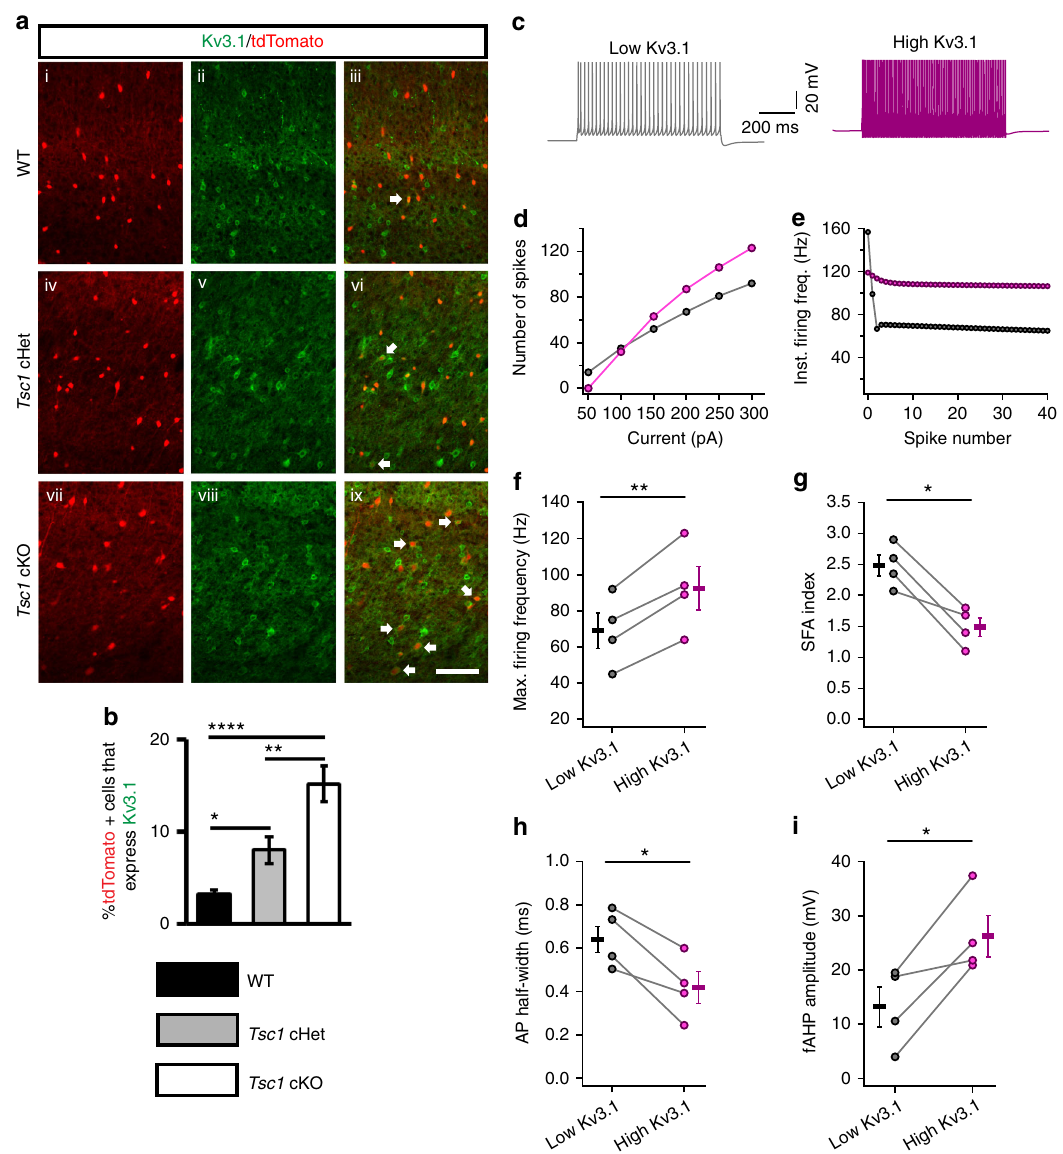
Fig. 4 Increased Kv3.1 channel expression in SST-Cre -lineage CINs underlie FS properties. a P35 coronal sections showing immuno fl uorescent labeling of Kv3.1 and tdTomato + cells from SST-Cre -lineages in the neocortices of WT (i – iii), Tsc1 cHets (iv – vi) and cKOs (vii – ix). Arrows denote co-labeled cells. Scale bar is 100 µ m. b Quanti fi cation of the %tdTomato + cells expressing Kv3.1: Chi-squared test with Yate ’ s correction, WT vs. cHet, p = 0.02 or cKO, p < 0.0001, and cHet vs. cKO, p = 0.008, n = 3, all groups (405 WT, 441 cHet and 446 cKO cells counted). c Example fi ring traces from a model of a layer 5 SST + CIN with low expression of Kv3.1 (grey) and high expression of Kv3.1 (purple). d , e Firing data from one representative model is shown. Increasing the conductance of Kv3.1 channel increases the number of APs fi red in response to depolarizing current injections ( d ) and decreases the change in instantaneous fi ring frequency during a train of APs ( e ). Increasing the Kv3.1 conductance in four different models of SST + CINs increases the maximum fi ring frequency: paired two-tailed t -test (t = 8.1, p = 0.003) ( f ) and decreases the spike frequency accommodation: SFA; paired two-tailed t -test (t = 4.9, 3 3 p = 0.016) ( g ). Increasing Kv3.1 conductance in models of SST + CINs decreases the duration of APs: paired two-tailed t -test (t = 4.7, p = 0.018) ( h) and 3 increases the fAHP: paired two-tailed t -test (t 3 = 3.8, p = 0.03) ( i ). Data are presented as mean ± S.E.M. * p < 0.05, ** p < 0.01, **** p < 0.0001. Source